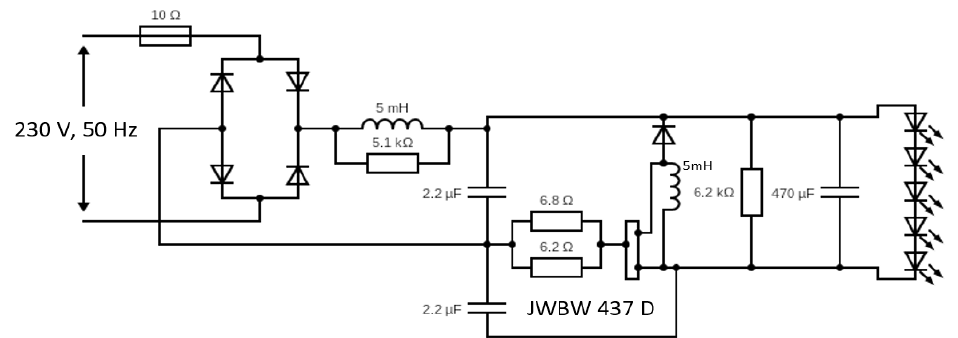
Figure 10. Simplified drawing of the circuit for Type A lamps.